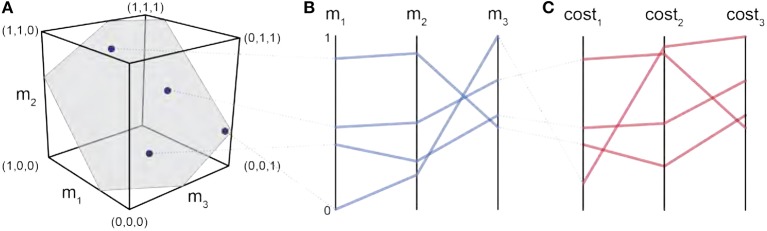
Parallel coordinates characterize the high-dimensional structure of a feasible activation spaces. Consider four points (i.e., muscle activation patterns) from the polygon that is a feasible activation space (A). The activation level for each muscle (i.e., the coordinates of each point) are sewn across three vertical parallel axes (B). As is common when evaluating muscle coordination patterns, each point can also be assigned a cost as per an assumed cost function. The associated cost for each muscle activation pattern can also be shown as an additional dimension. We show three representative cost functions (C). Activation levels are bound between 0 and 1, and costs are normalized to their respective observed ranges.